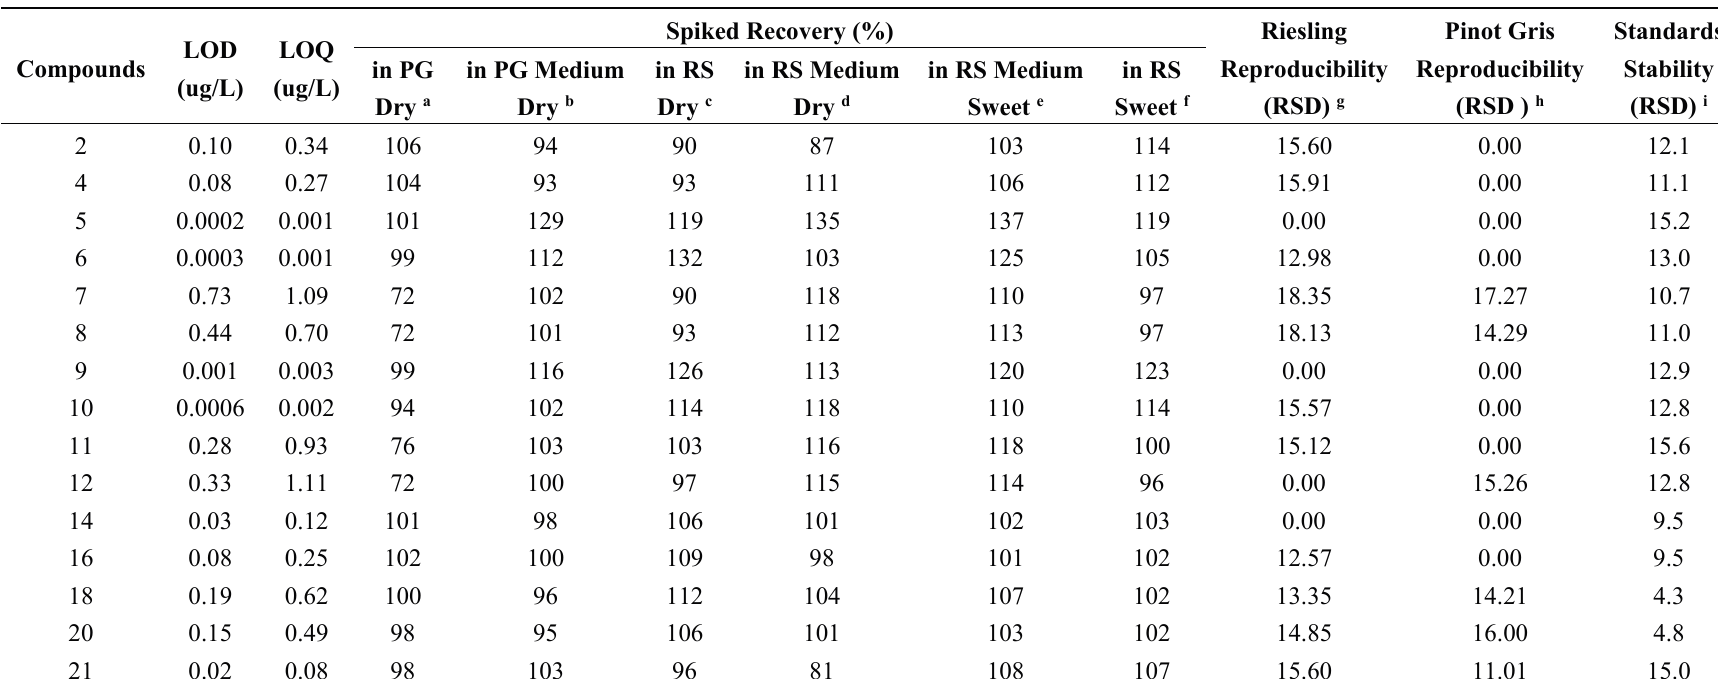
Table 2. LOD, LOQ, percent spiked recovery, reproducibility and standard stability for wine samples with different matrix.